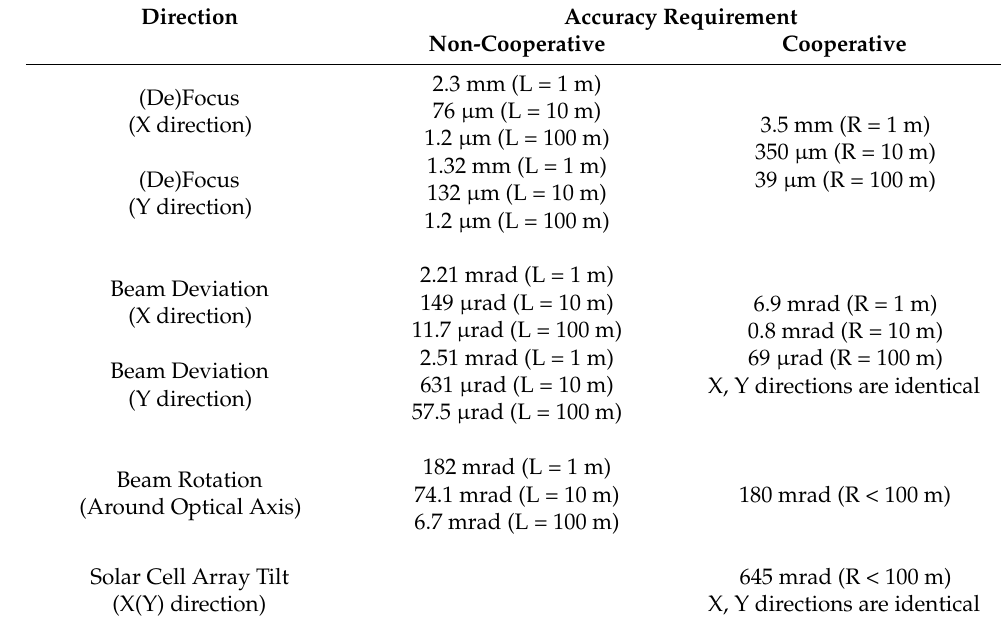
Table 1. Requirements for focus adjustment and beam